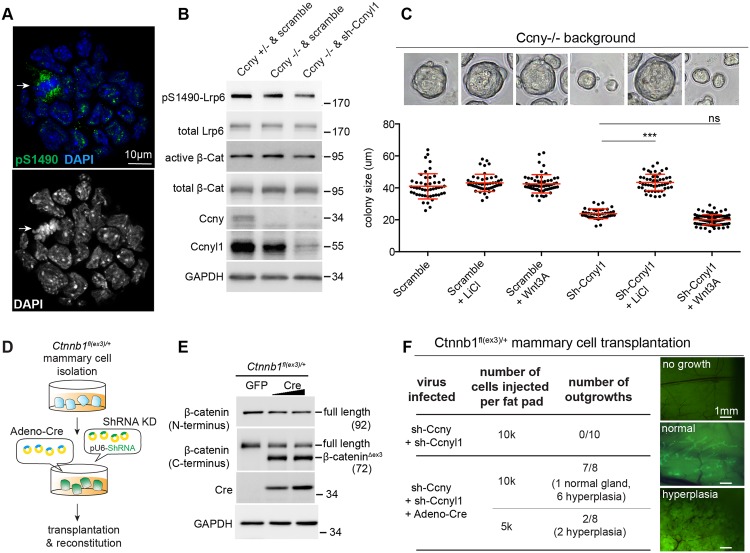
Constitutively active β-catenin rescues the Ccnys depletion-induced basal stem/progenitor cell defect.(A) Lrp6 Ser1490 phosphorylation staining in a basal colony. Basal cells were isolated from two 8-week old CD1 mice and culture in Matrigel for 6 days. Colonies were stained with anti-phospho-Ser1490 Lrp6 antibody (green). DNA was stained by DAPI (blue). The arrow indicates a mitotic cell in the colony. (B) Ccnys-depletion attenuates Lrp6 Ser1490 phosphorylation and β-Catenin activation in primary mammary cells. All mammary cells were isolated from 10-week-old Ccny-/- mice and their Ccny+/- littermate, respectively, and infected with scramble or sh-Ccnyl1 lentivirus. After 72 h of culture, the cells were treated with 200 ng ml-1 Wnt3A for another 16 h. Total cell lysates were then prepared and analyzed by western blotting. GAPDH served as loading control. Shown data are representative of three independent experiments.(C) LiCl restored the size of basal colonies to the normal range. Primary basal cells (Lin-,CD24+,CD29hi) were sorted from 8-week-old Ccny-/- mammary glands, followed by infection of scramble or sh-Ccnyl1 lentivirus and culture in Matrigel. 200 ng ml-1 Wnt3A was added at day 1 or 3 mM LiCl was added at day 3. The colony sizes were measured at day 6. Data are presented as mean±s.e.m. Student’s t test: ***p<0.001. (D) Illustration of rescuing the regenerative capacity of Ccnys-deficient stem/progenitor cells by constitutively active β-catenin. All mammary epithelial cells were sorted out from 12-week-old Ctnnb1flox(ex3)/+ mice and virally infected with Adeno-Cre, Ccny-shRNA-mCherry and Ccnyl1-shRNA-GFP. GFP and mCherry double positive cells were FACS-isolated and transplanted. (E) Western analysis validating the generation of β-CateninΔex3, a constitutively active form of β-Catenin, after Cre-mediated recombination. (F)
Ctnnb1flox(ex3)/+ mammary cells were virally infected as indicated, followed by FACS-isolation and transplantation. Recipient fat pads were harvested at 8 weeks post transplantation and analyzed for mammary outgrowth. Ctnnb1flox(ex3)/+ cells with Ccnys-knockdown (infected with only the shRNAs) were not able to reconstitute any outgrowth, whereas Ctnnb1flox(ex3)/+ cells infected with both the shRNAs and Adeno-Cre efficiently generated outgrowth, often with hyperplasia formation. Representative images are shown. Results are combined from three independent experiments.